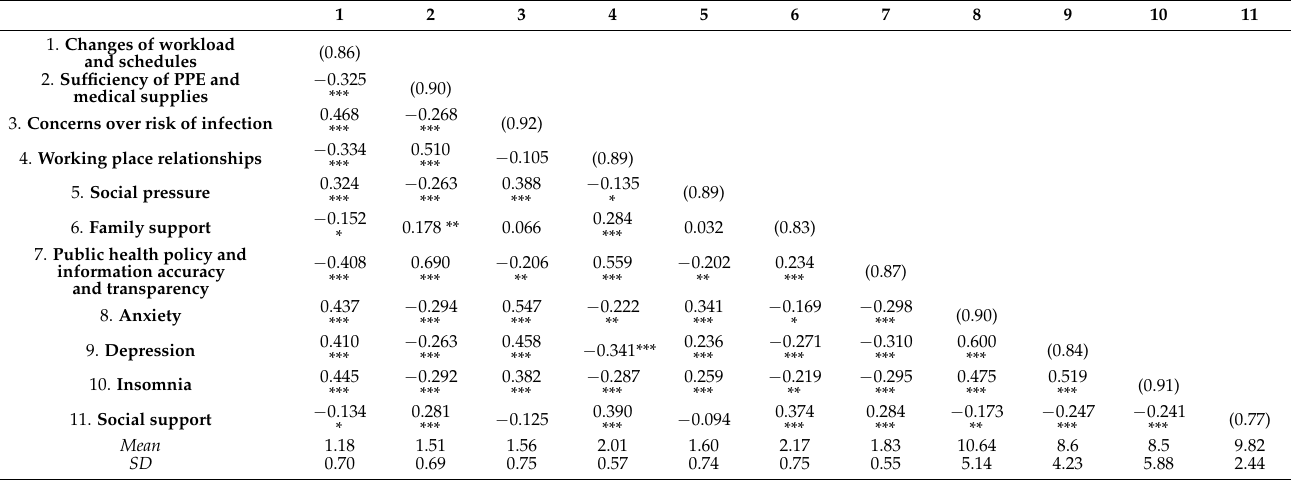
Table 5. Pearson correlation: extrinsic factors, anxiety, depression, insomnia and social support.